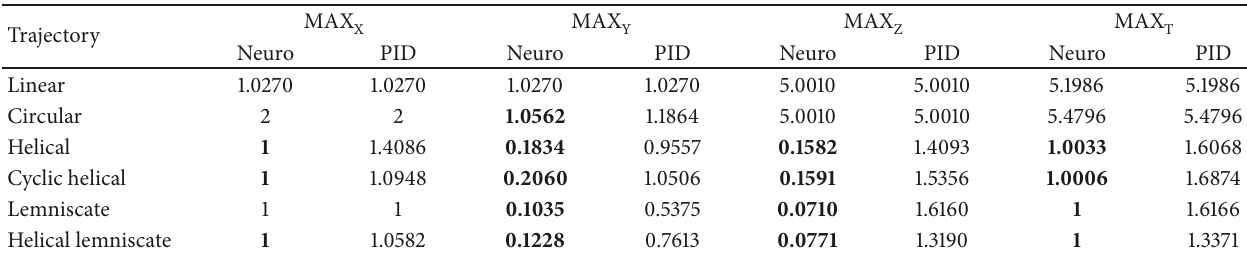
Table 6: Comparison of the MAX of the tracking error for different trajectories with wind